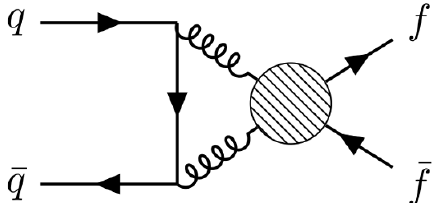
Figure 5 . Operator mixing: (cid:22) qP X q (cid:22) ‘P Y ‘ induced at one-loop order nucleus